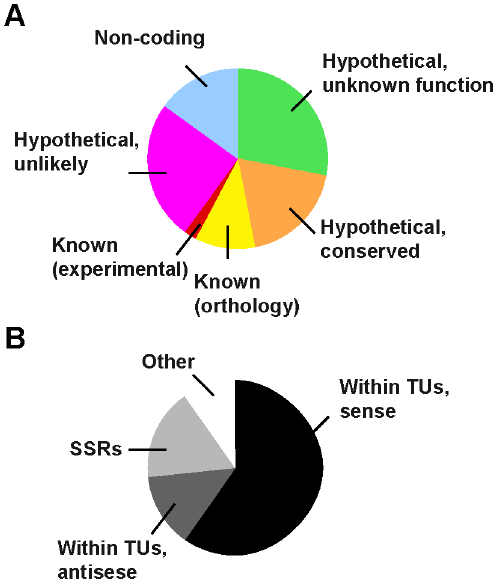
Figure 3. Distribution of RBP33-bound transcripts. (A) RNAs associated with RBP33 (log 2 FC . 3) were categorized according to whether they are predicted to encode functional proteins. Color code is based on that of GeneDB (http://www.genedb.org/Homepage/ Tbruceibrucei927). (B) Localization of the genes encoding RBP33 targets (log 2 FC . 3) on the genome. ‘SSR’ refers to genes localized in the vicinity of strand-switch regions, whereas ‘Other’ indicates genes found close to the beginning or end of chromosomes, or close to snoRNA or pseudogene clusters.